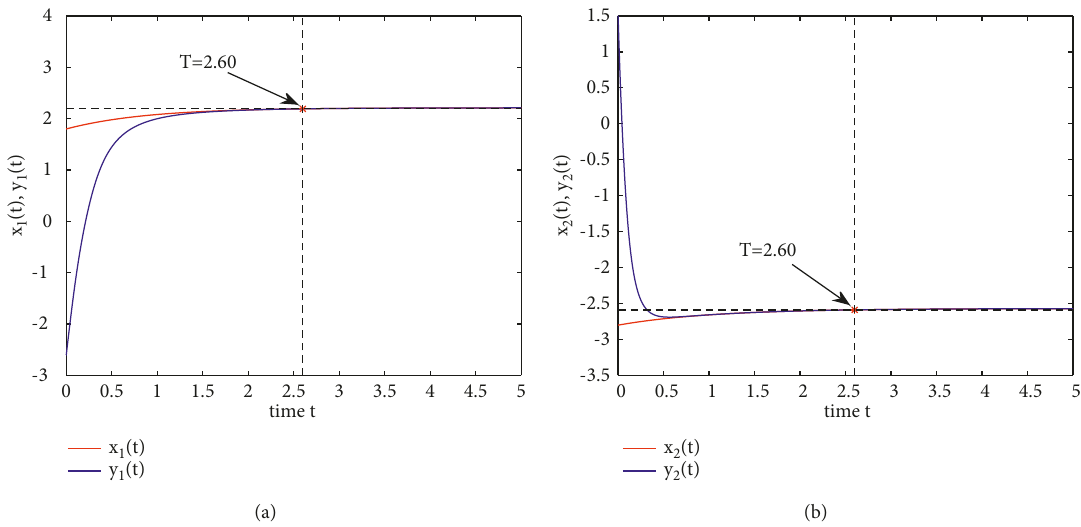
Figure 11: (a) Trajectories of x response system under controller (62).